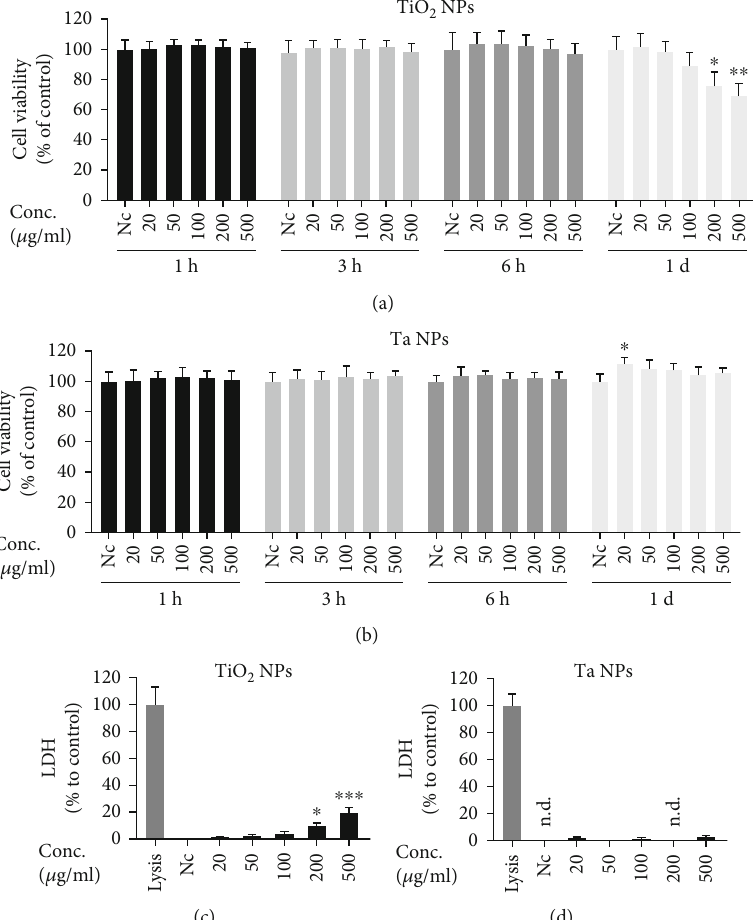
Figure 3: Analysis of cytotoxic e ff ects of TiO and Ta NPs on macrophages. (a, b) Cell viability was determined by CCK-8 assay at indicated 2 time points. (c, d) Lactate dehydrogenase (LDH) leakage was evaluated by LDH assay after 24h. Viability and LDH release are normalized and expressed as mean + SD as percentage of untreated cells of three independent experiments ( ∗ p < 0 : 05 , ∗∗ p < 0 : 01 , and ∗∗∗ p < 0 : 001 ). n.d.: not detectable. Nc: nontreated